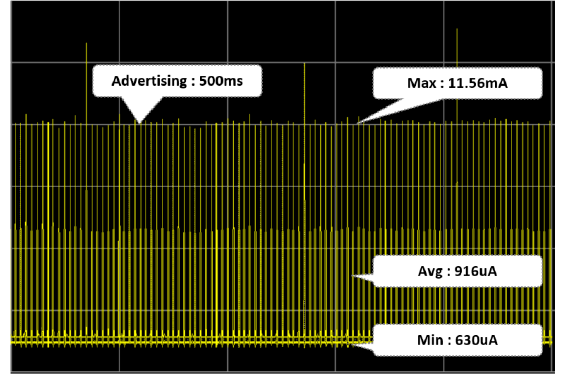
Figure 12. Power status of smart tag (Idle Mode).